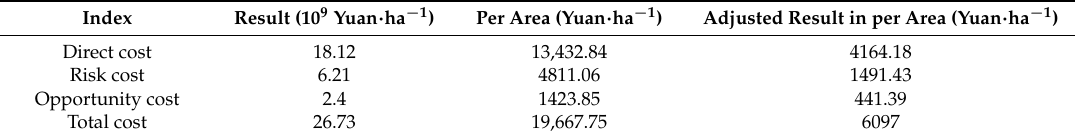
Table 10. Total cost of forest in Yanqing District in